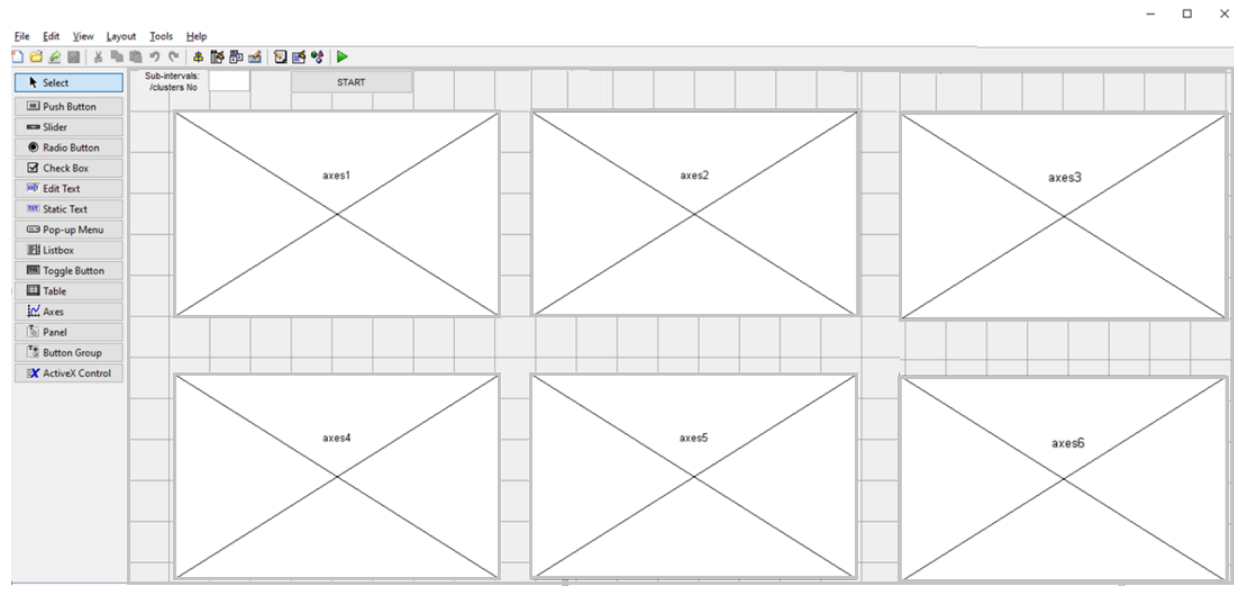
Figure 1. The interface.